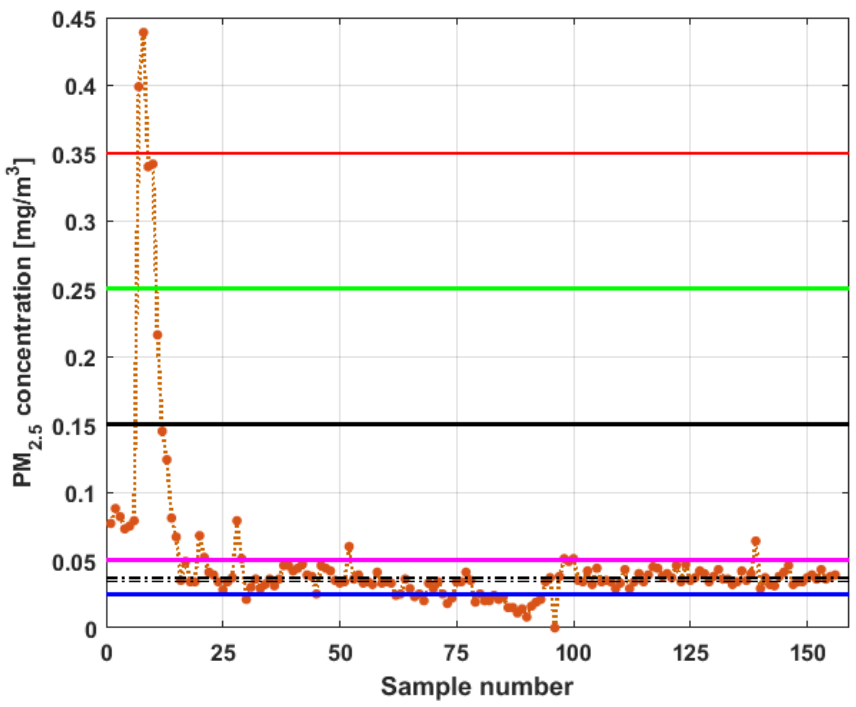
Figure 11. Observations of variable X 1 , together with the 95% nonparametric confidence interval for the median (shown with dashed black lines) and the limits that define the categories of the level of air pollution by PM 2.5 (Desirable level: Blue line; Acceptable level: Magenta line; Caution level: Black line; Alarm level: Green line; Emergency level: Red line).